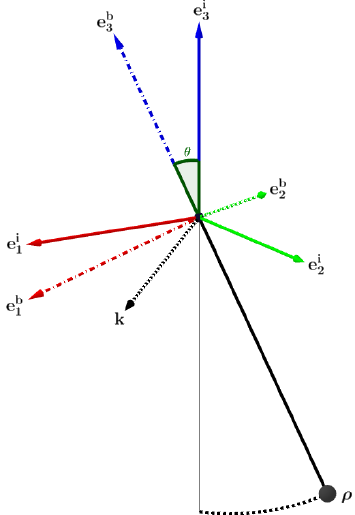
Figure 4: Let the third principal axis of the body frame, e b , 3 be co-linear with the direction of the observed line. The stable attitude is defined as the line with direction vector that is co-linear with the third principal axis of the inertial frame, e i . The 3 composite rotation can be expressed as a rotation = exp ( θ k × ) about a single axis, k , as R i b